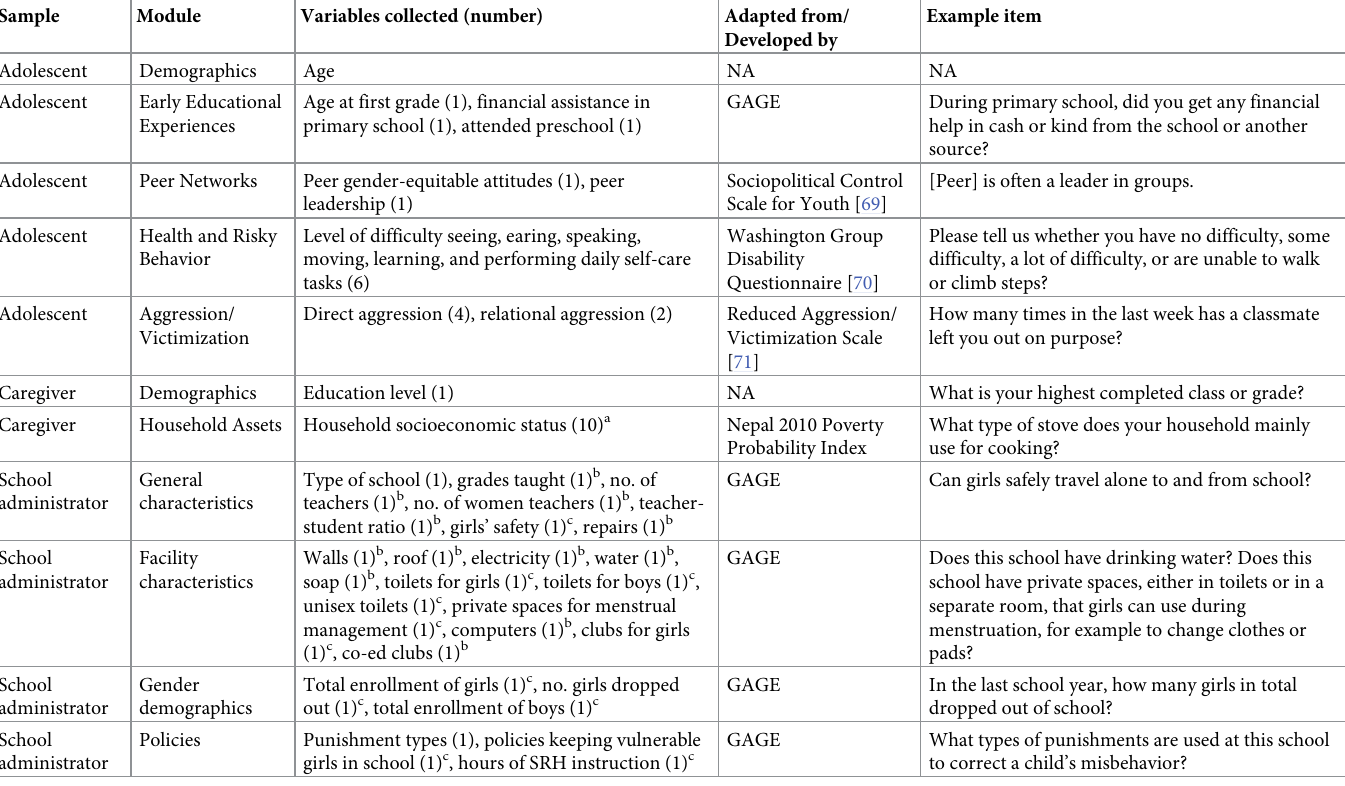
Table 1. Survey modules and items